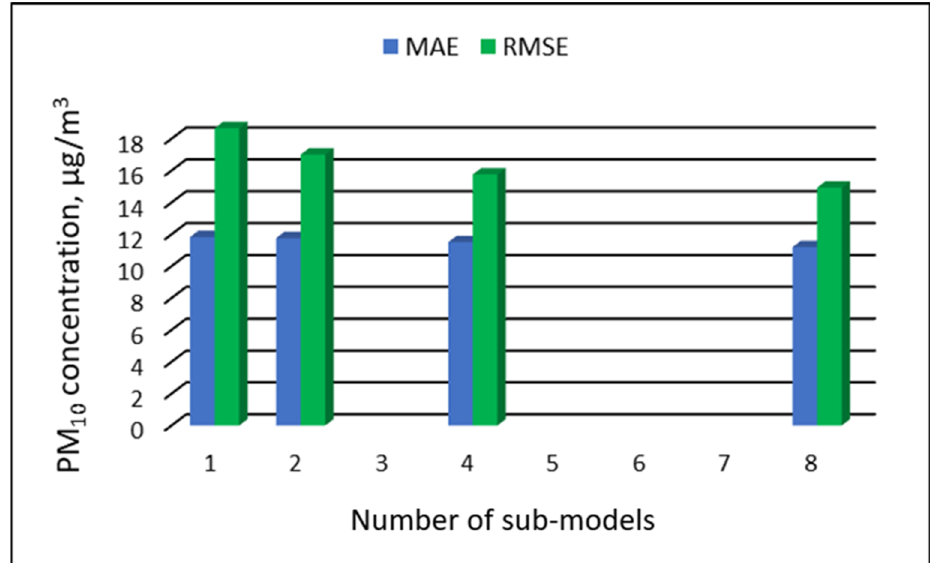
Table 20. Values of approximation errors of PM 10 concentrations in PVS models, Z ł oty Potok 2011– 2016.